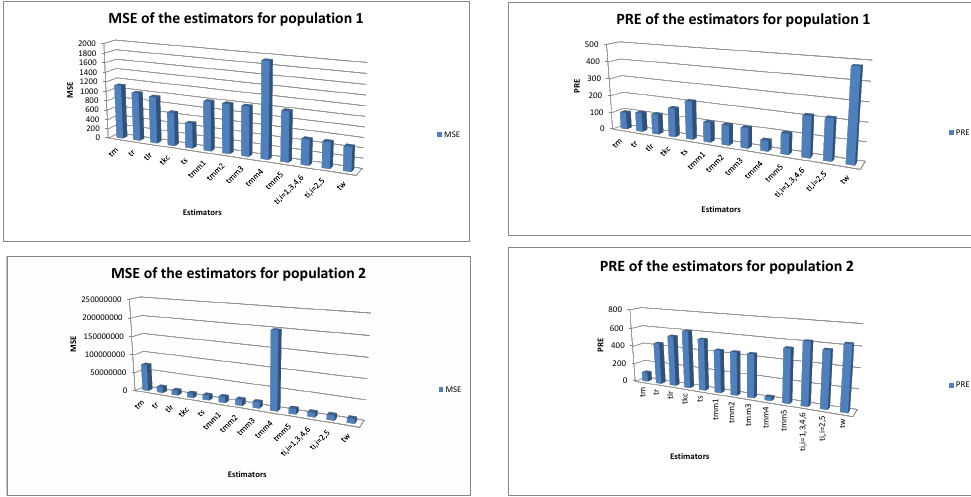
Figure 1. MSE and PRE of the estimators for real